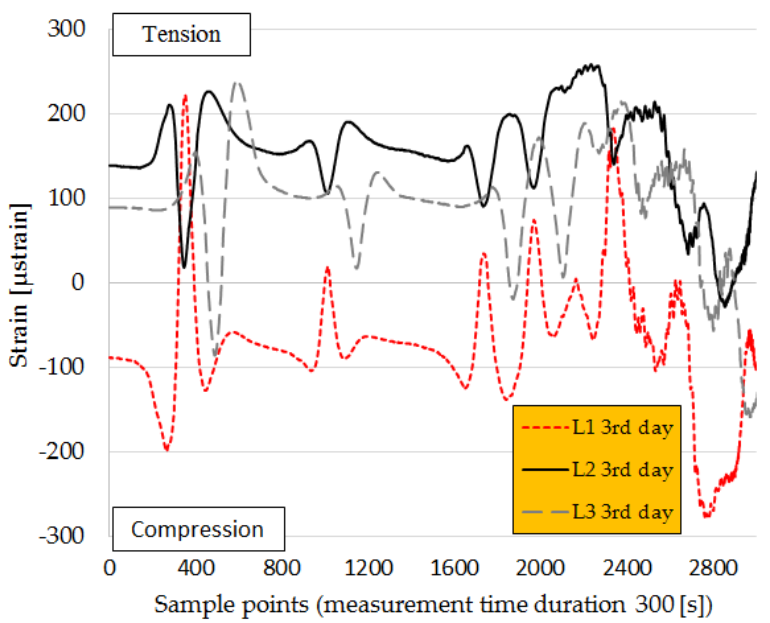
Figure 12. Strain values of sensors L1 and L2 during the construction of the CyPaTs asphalt pavement on the second day.